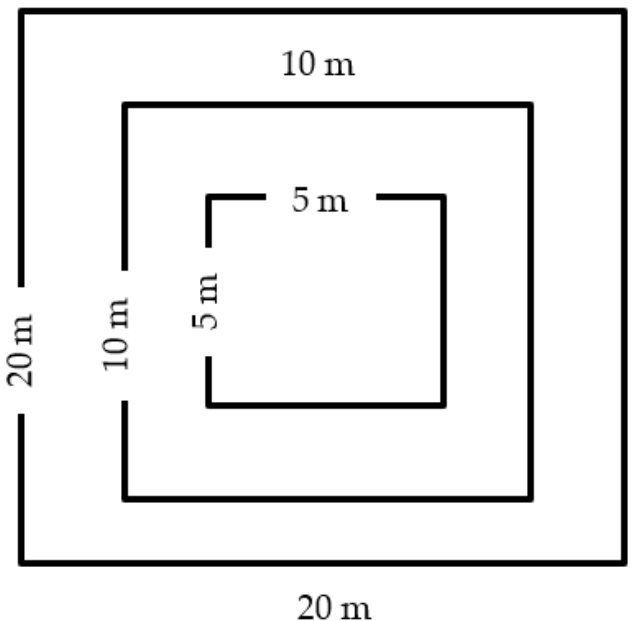
Figure 3. A sample quadrat plot (20 × 20 m 2 ) with sub and sub–sub plot.